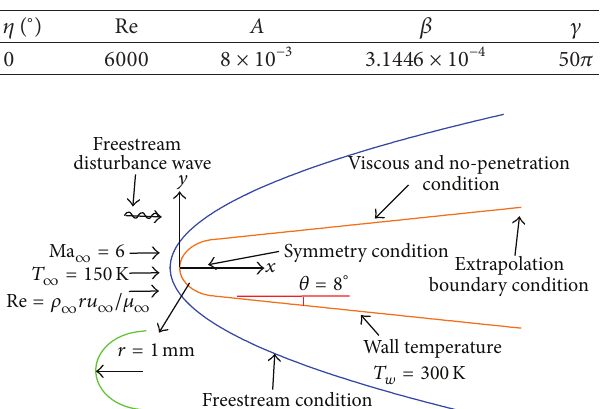
Table 1: Computational conditions.